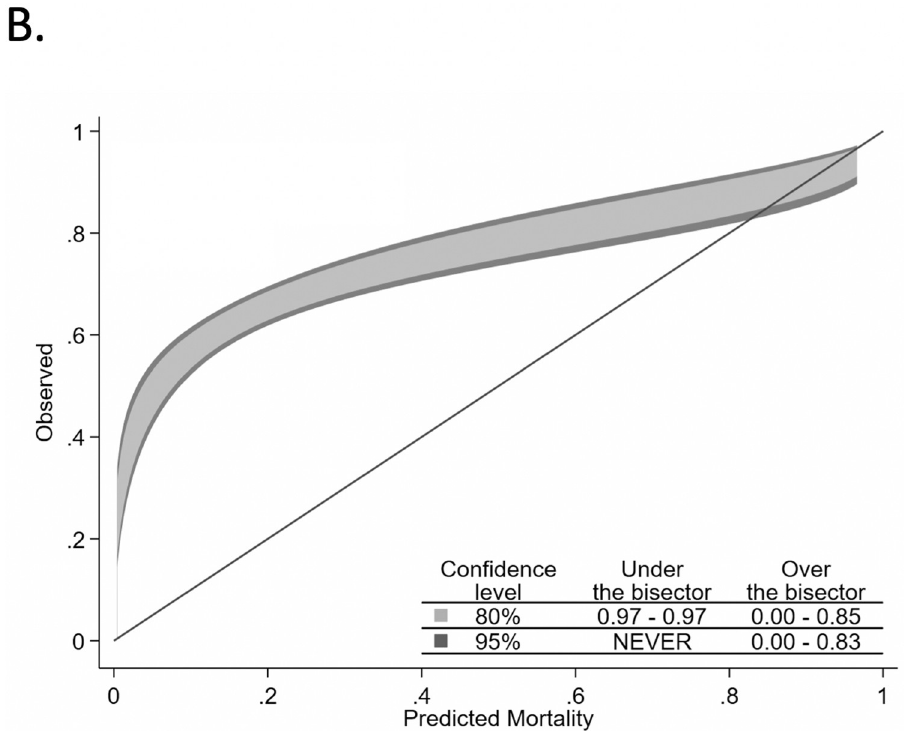
Fig 3. Comparative calibration belt plots for APACHE